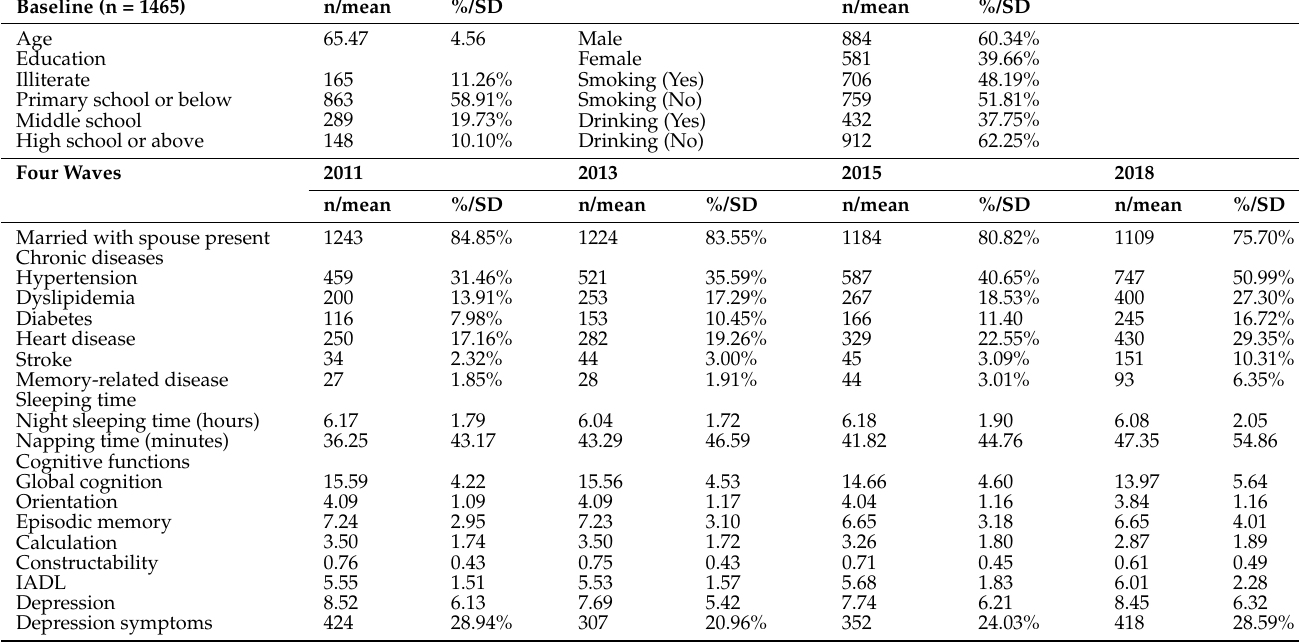
Table 1. Descriptive statistics of sample